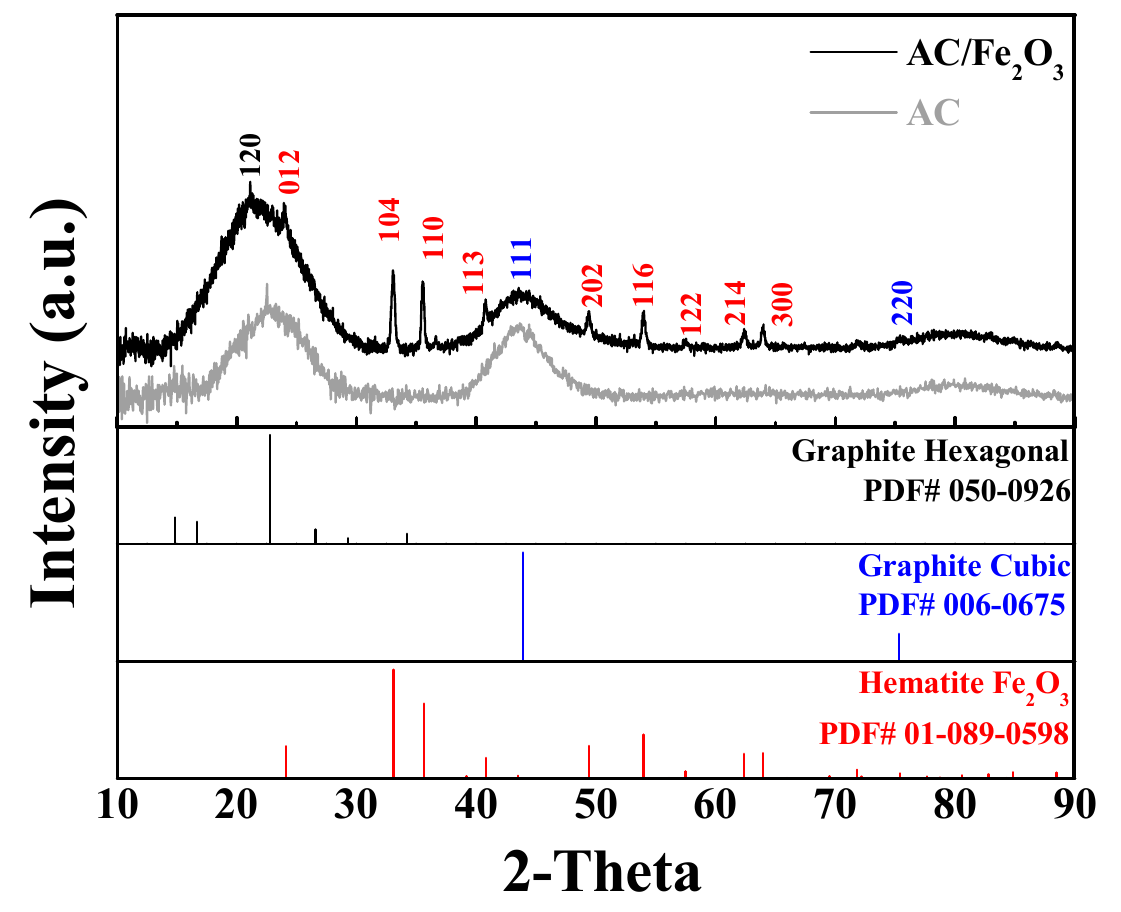
Figure 3. XRD patterns of AC and AC/Fe 2 O 3 nanocomposite. Table 1. Lattice parameters of Fe 2 O 3